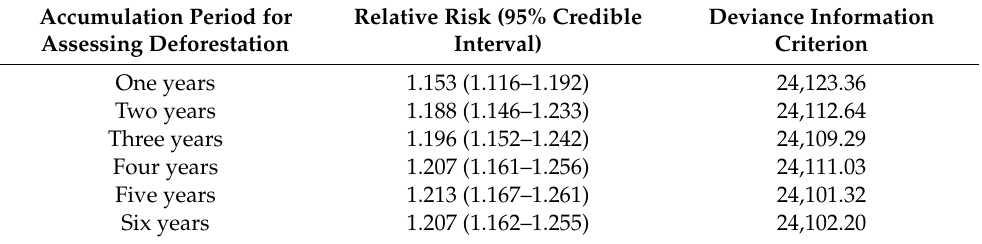
Table 5. The results of the sensitivity analysis using di ff erent deforestation accumulation